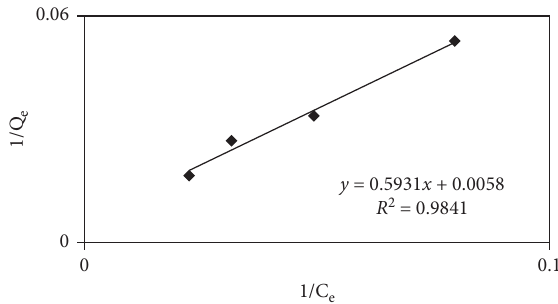
Figure 16: Linearity of Langmuir model.